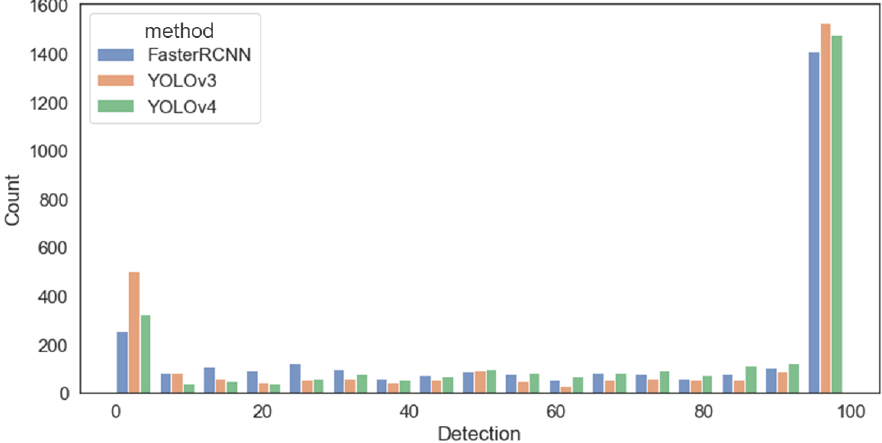
Figure 6. Distribution of detection by method according to the amount of data.